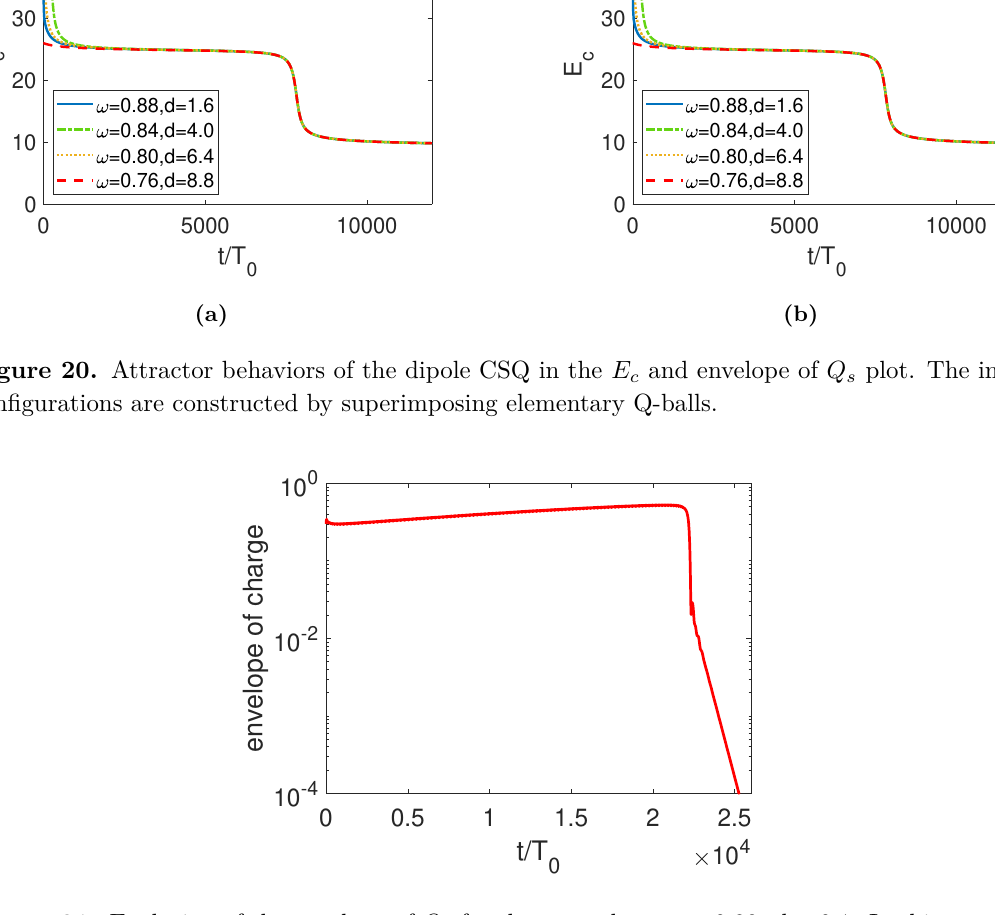
Figure 21. Evolution of the envelope of Q s for the case where ω = 0 . 88 , d = 0 . 1 . In this case, the initial amplitude of Q is smaller than the steady value of the CSQ, and the amplitude of Q s increase from 0 . 29 to 0 . 53 before the decay of the CSQ. This leads to a longer